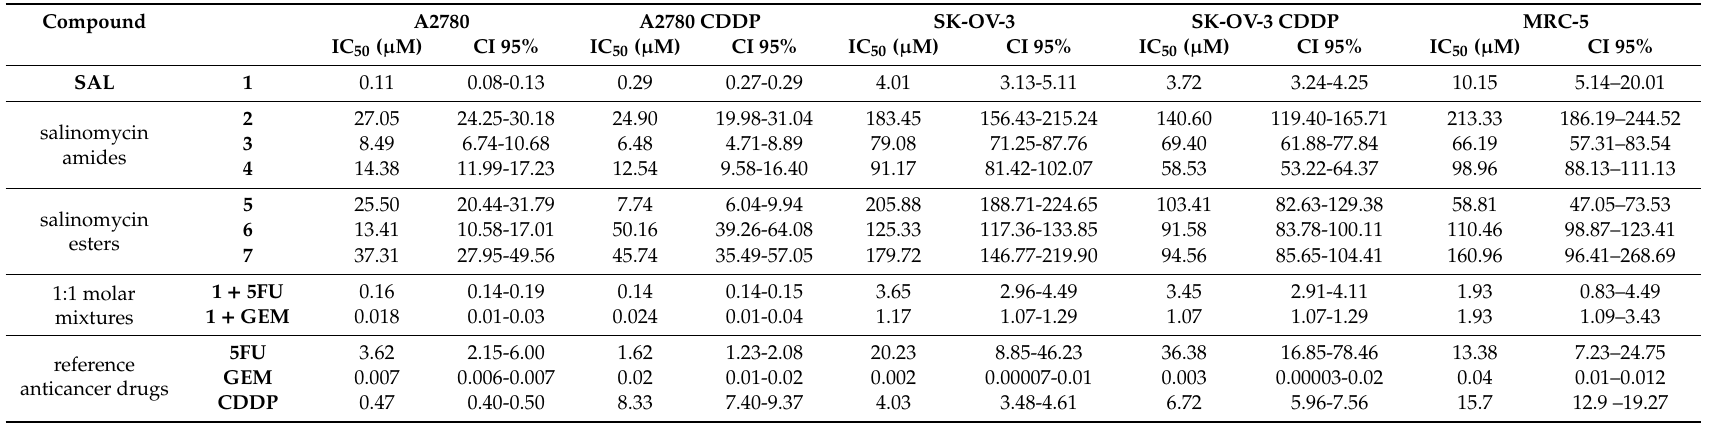
Table 1. The IC 50 values estimated for ovarian cancer cell lines (A2780, SK-OV-3, both drug-sensitive and drug-resistant variants) and normal diploid human MRC-5 cell line after 72 h exposure to salinomycin ( SAL , 1 ), its 1:1 molar mixtures with cytotoxic drugs (5-fluorouracil 5FU , gemcitabine GEM ), and salinomycin amides and esters (analogs 2–7